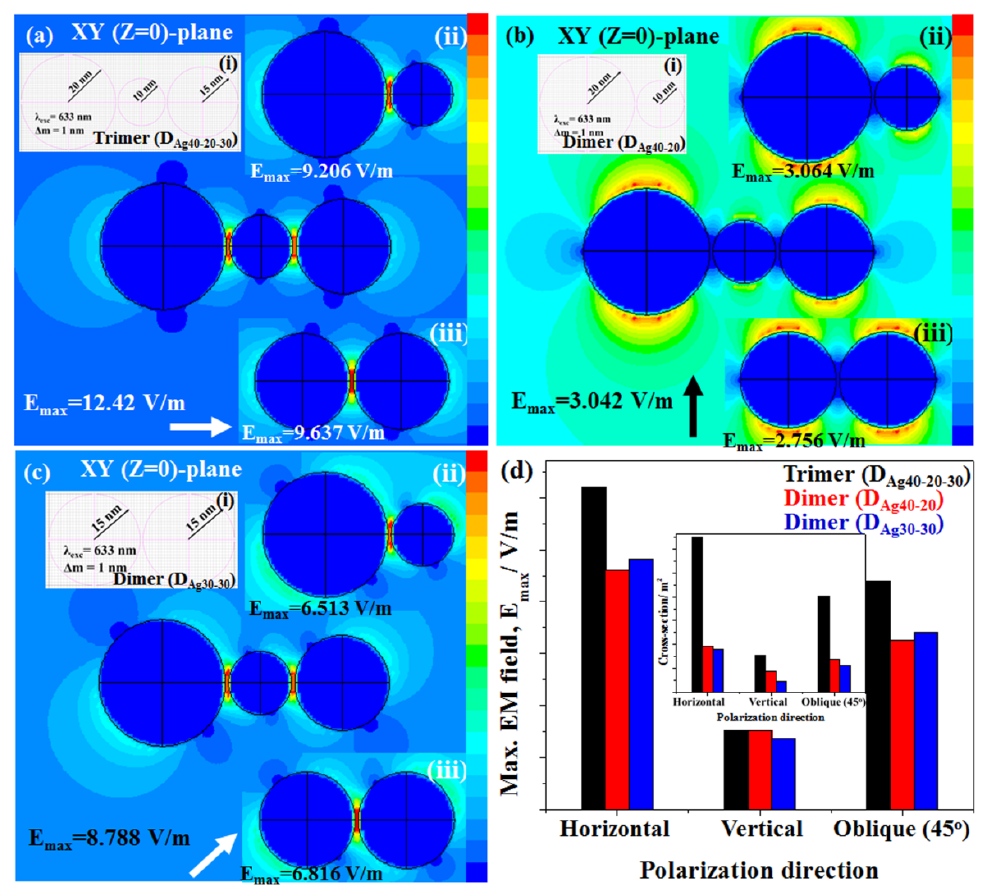
Figure 5. ( a – c ) EM near-field distribution of a typical Ag-NPs-based trimer model geometry excited at s-, p- and 45° of incident polarizations, respectively; inset (i): Corresponding model geometry along with simulation parameters and inset (ii) and (iii): EM near-field distribution of the dimer of same NPs size and that of different NPs size, respectively. Corresponding arrows and color bars represent the polarization directions and respective intensities observed under the simulations and ( d ) Maximum EM near-field of trimer and dimers simulated at s-, p- and 45° of incident polarizations; inset: Bar graph of forward cross-sections as obtained in FDTD simulations of trimer and dimers at s-, p- and 45° of incident polarizations.